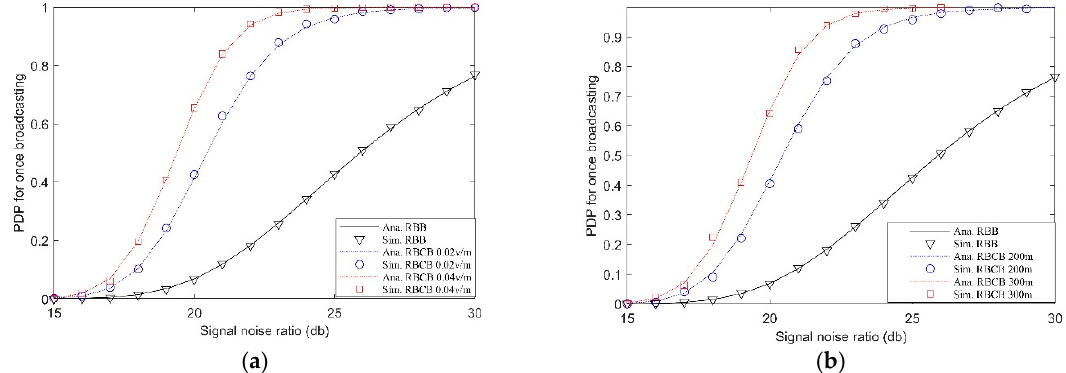
Figure 8. Comparison of the packet delivery probability (PDP) for once broadcasting. ( a ) the transmission range is 200 m, ( b ) the density of vehicles is 0.02 v/m.